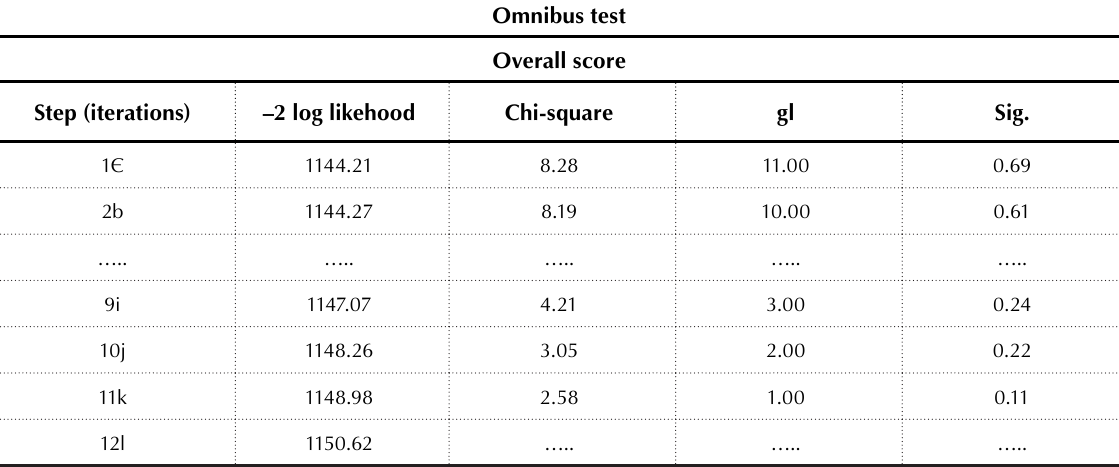
Table 8. Proportional risk function for all companies of the sample (like these following the same failure